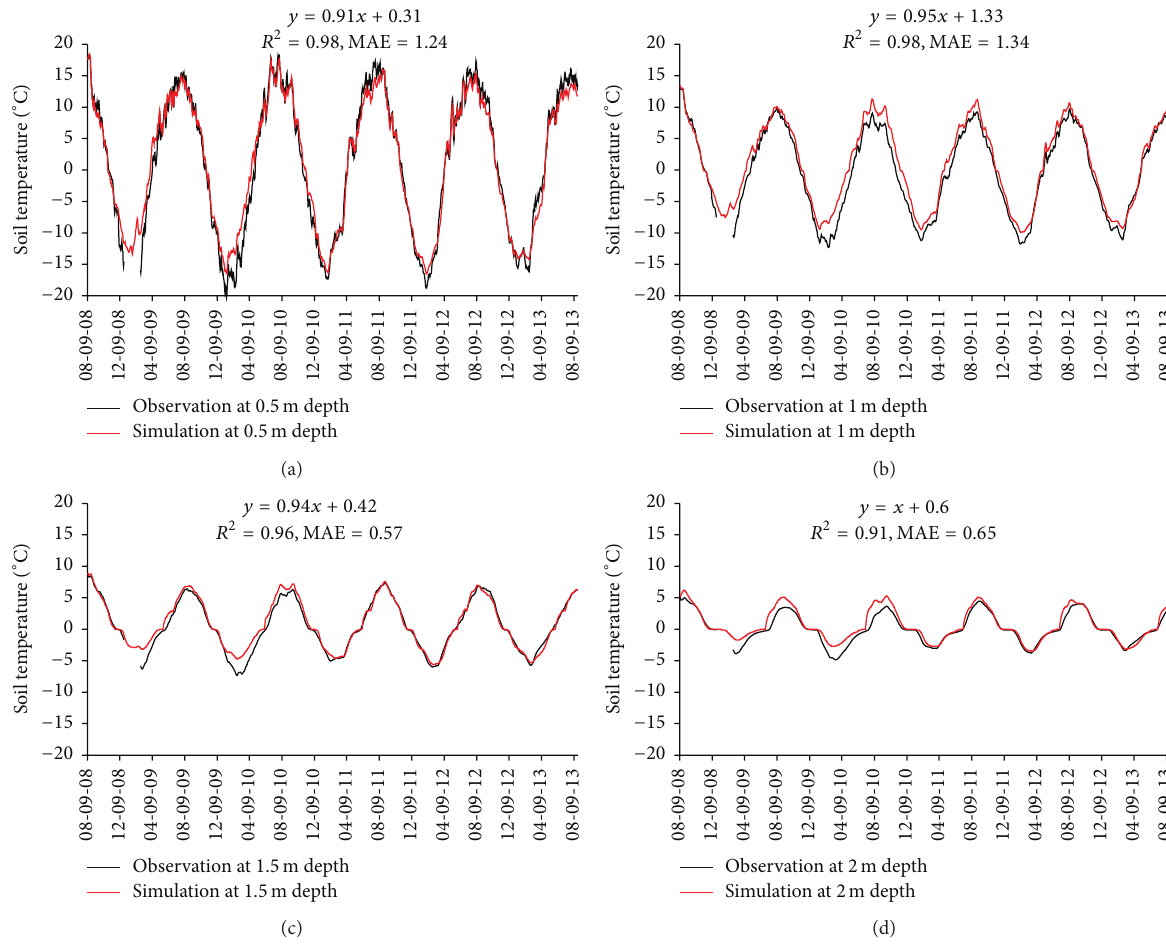
Figure 2: Comparison of simulated and observed soil temperature at the depths of 0.5 m, 1m, 1.5 m, and 2 m, respectively. A linear analysis was conducted for each comparison, where 𝑅 2 is the coefficient of determination and MAE is the mean absolute